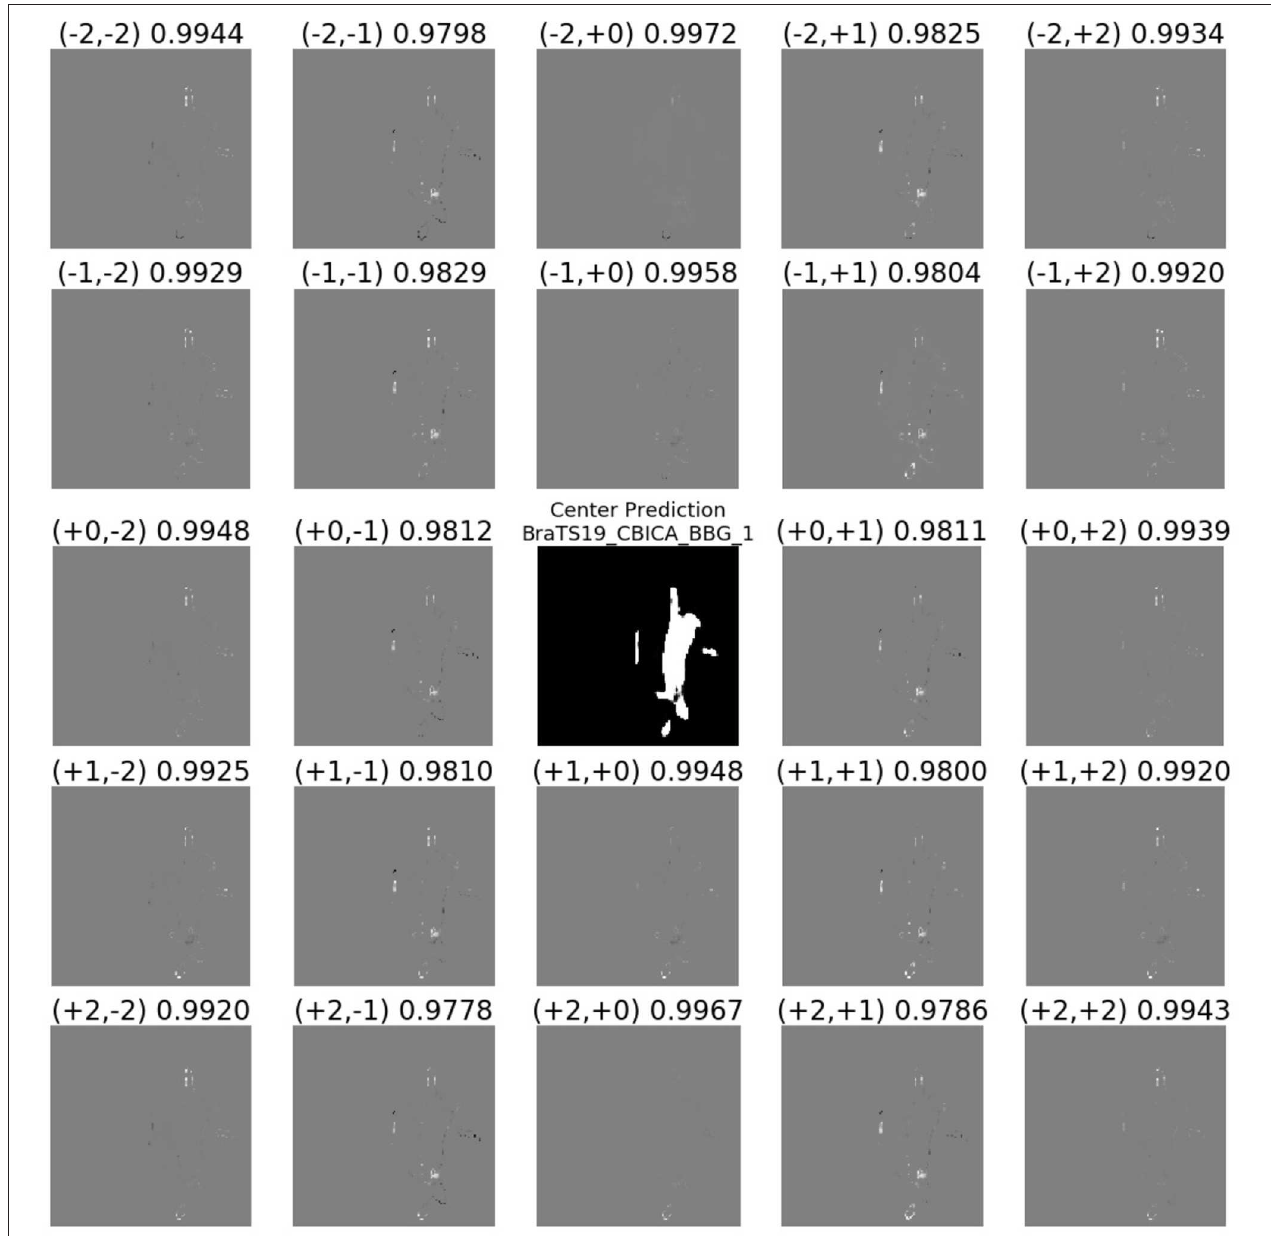
FIGURE 9 | Demonstrating the translational variance of the 2D BraTS model. The center shows the prediction of the model on a 128 × 128 center crop of the MRI. Note the entire tumor fits within this tile. The surrounding subplots show the difference in the prediction as the MRI input crop is offset by one or two pixels in either dimension of the slice. The differences between the predictions in the overlapping pixels show that even the smallest translation in the input can create a difference in the output. Gray pixels indicate no difference in the predictions of the overlapping pixels between the center crop and the offset crop, black pixels are in the offset-crop prediction but are not present in the center-crop prediction, and white pixels are in the center-crop prediction but are not present in the offset-crop prediction.